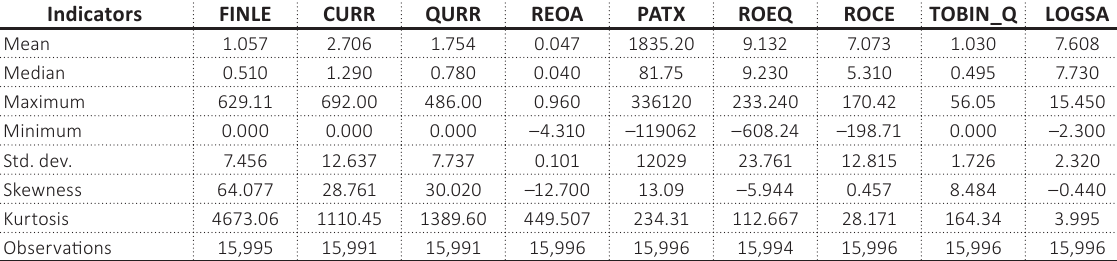
Table 3. Descriptive